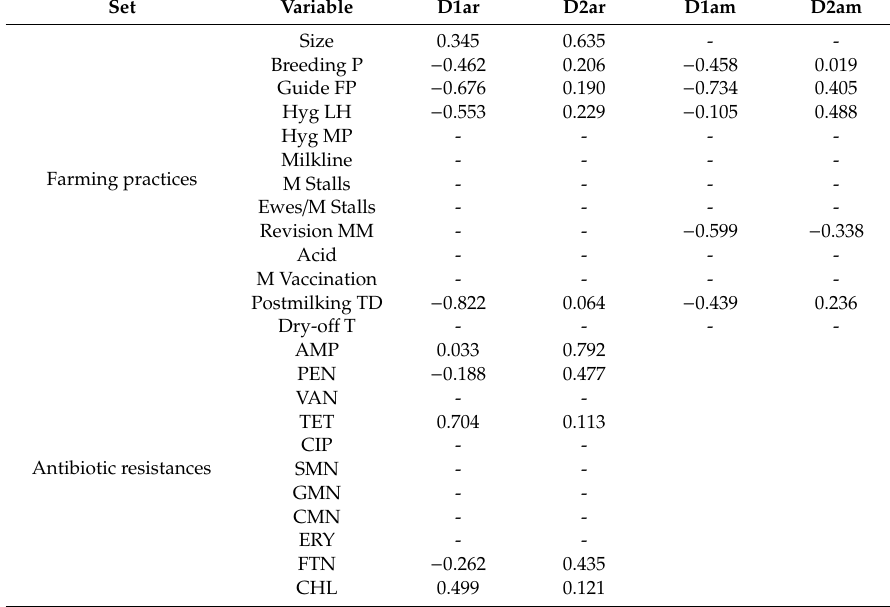
Table 5. The component loadings of variables in the analysis of nonlinear canonical correlation analysis